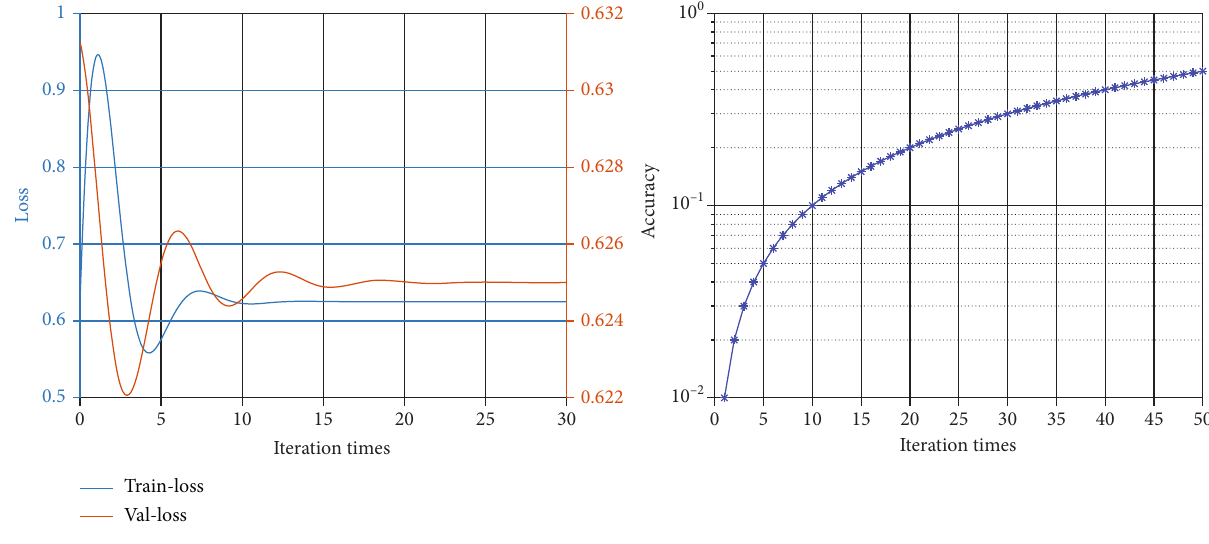
Figure 5: Loss and accuracy curves.